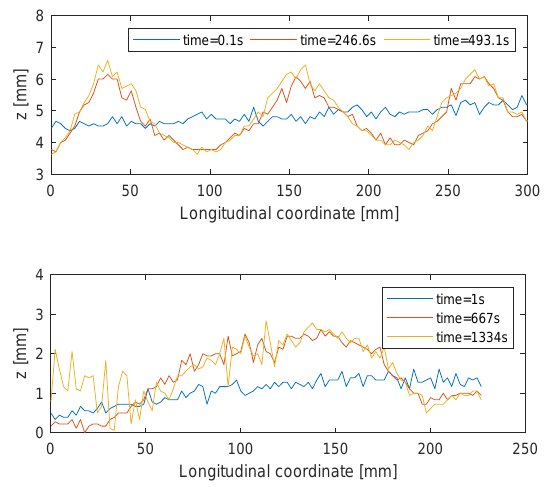
Fig. 5 : Profiles at di ff erent times of run n.70 (above) and run n.166 (below) without the background images (the conversion be- tween pixel and cm is the same of the previous two figures).